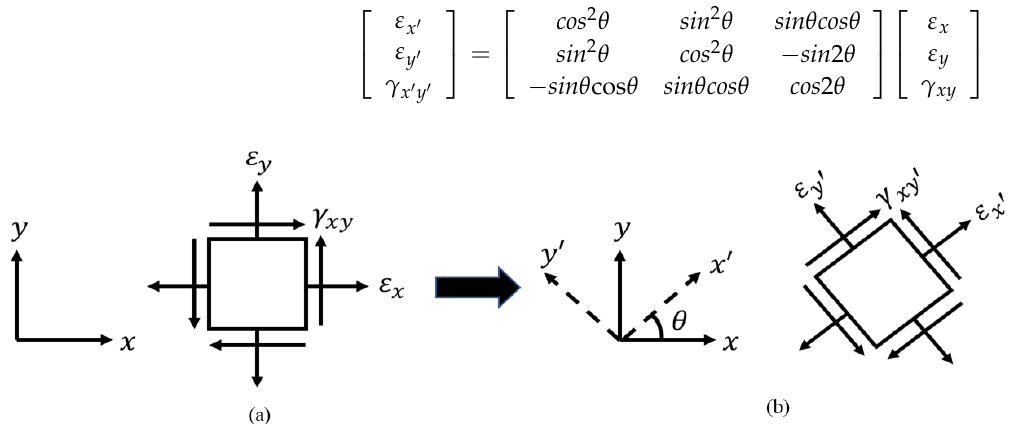
Figure 3. 2D solid element in: ( a ) x − y coordinate system; ( b ) x (cid:48) − y (cid:48) coordinate system.